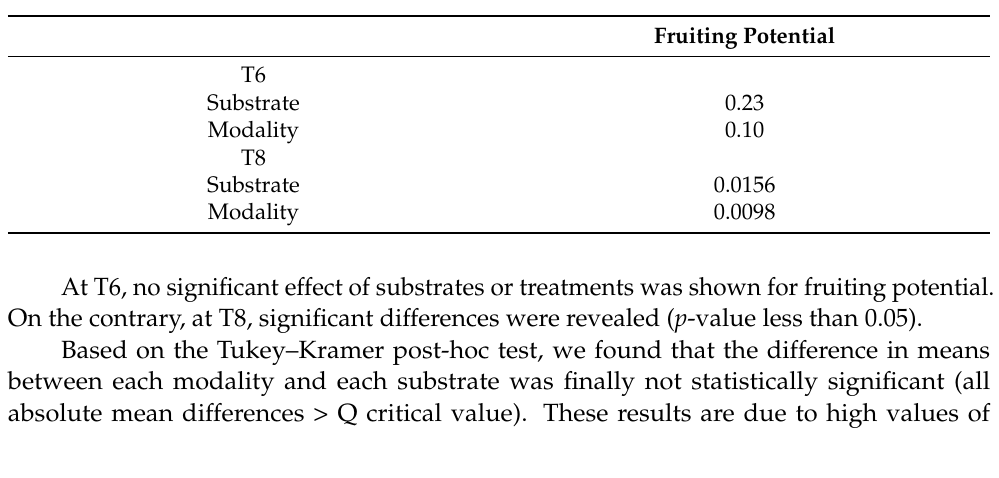
Table 5. Probabilities obtained with one-way ANOVA ( p -value threshold 0.05) performed on fruiting potential at T6 and T8 considering substrates used in one hand and modalities in the